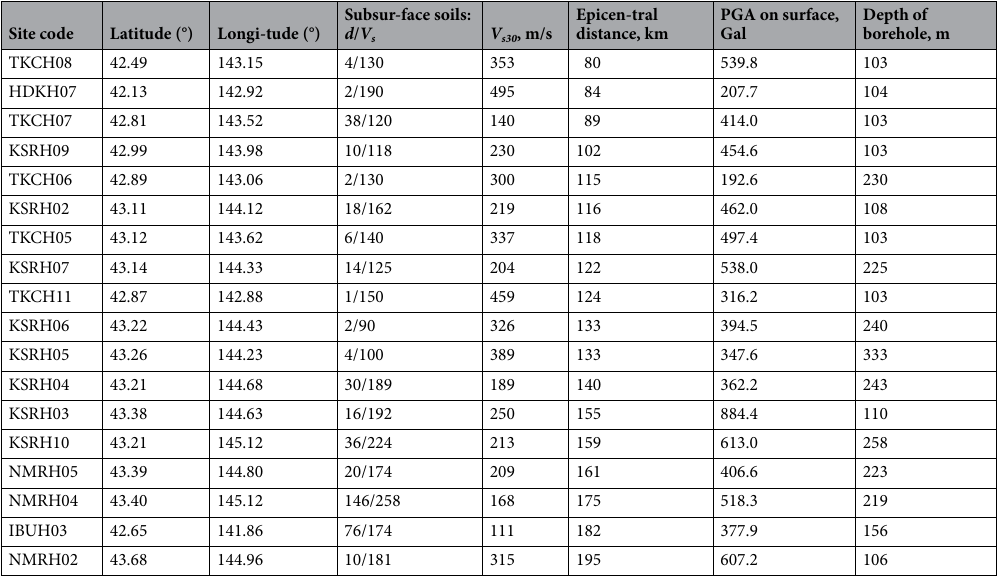
Table 1. Information on the KiK-net sites, for which models of soil behavior during the 2003 Tokachi-oki earthquake were